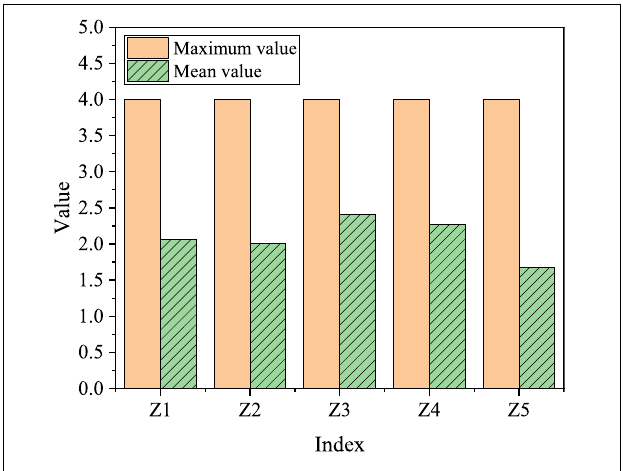
FIGURE 9 | Evaluation and statistics of college students on school entrepreneurship policy.